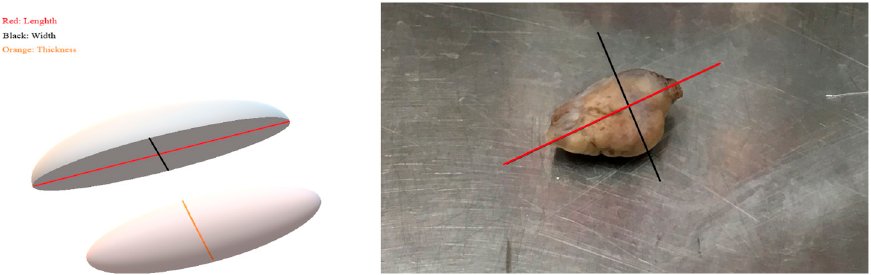
Figure 1. Graphical demonstration of the measured parameters. Macroscopic appearance of human ovary and demonstration of measured parameters; with red axis for length; black axis for width; orange axis for thickness.